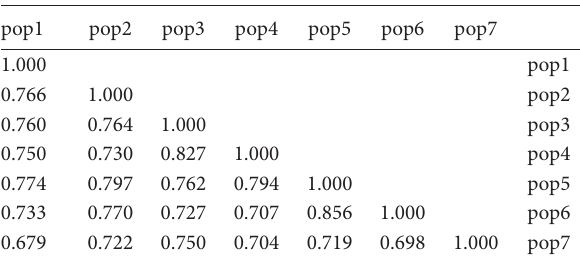
Table 4. Analysis of molecular variance (AMOVA) of the studied species.